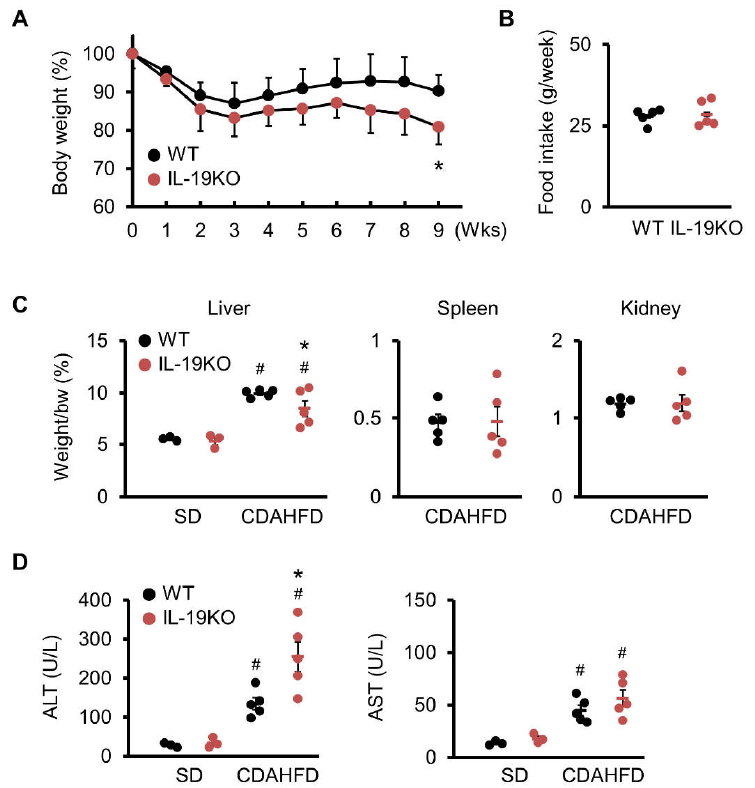
Figure 2. The changes in body weight, food intake, organ weights, and serum ALT and AST levels. WT ( n = 15) and IL-19 KO ( n = 15) mice were fed a CDAHFD diet for 9 weeks. Body weight ( n = 15) ( A ) and food intake ( n = 5) ( B ) were monitored weekly. ( C ) Liver weight, spleen weight, and kidney weight were determined at week 9 ( n = 5). Liver weight was also measured in the SD-fed group ( n = 3). ( D ) The ALT and AST levels in the serum were measured ( n = 5). The ALT and AST levels in the SD group was also measured as a control group ( n = 3). * p < 0.05 vs. WT. # p < 0.05 vs. SD.